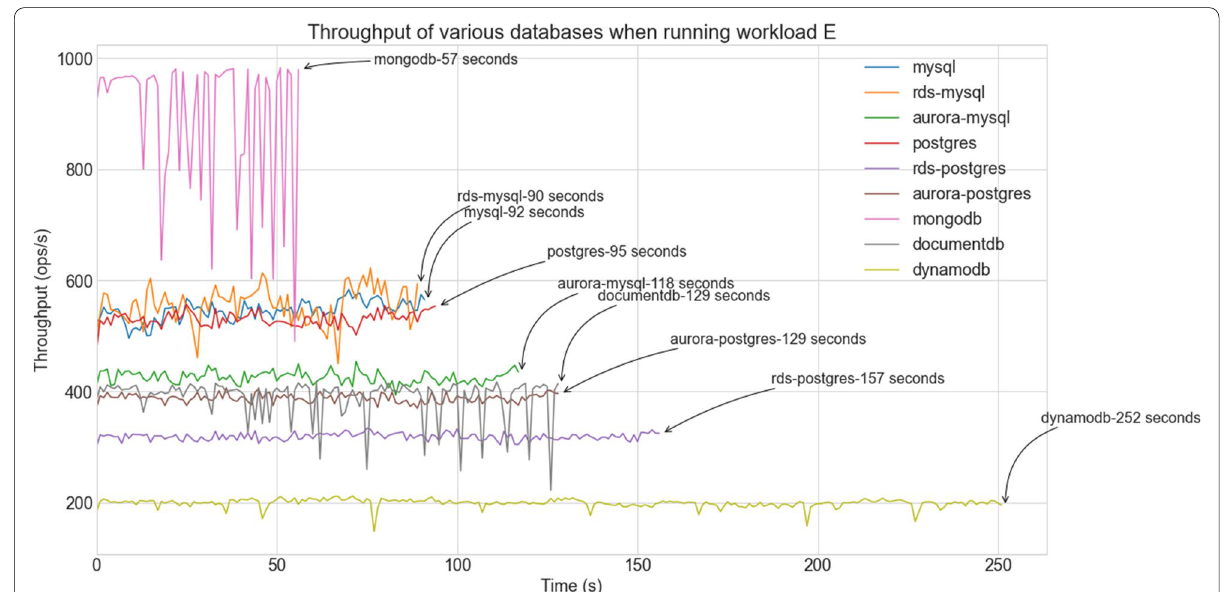
Fig. 9 Performance of databases with Workload‑e (equal number of read, inserts and